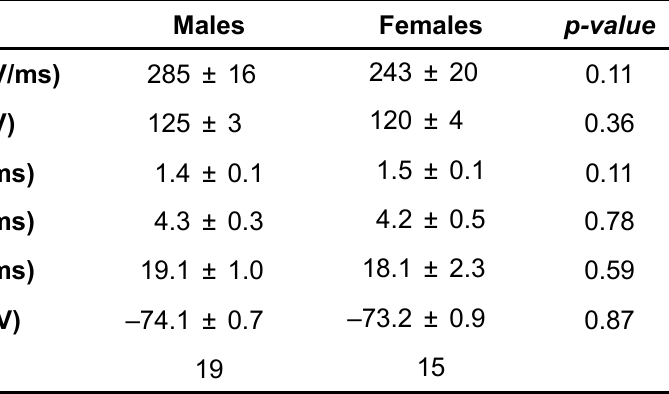
Figure 1. Similar action potential configuration in left atrial myocytes of male and female mice. ( A ) . Representative recordings of male (black) and female (red) action potentials recorded using perforated patch-clamp techniques at 4 Hz at 37 °C. Dotted line displays 0 mV. ( B ) . Summary table of mean values of action potential parameters: maximum upstroke velocity (Vmax), action potential amplitude (APA), action potential duration at 20, 50 and 90% of repolarization (APD 20 , APD 50 or APD 90 ) and resting membrane potential (RMP). No statistical difference was observed between males and females.